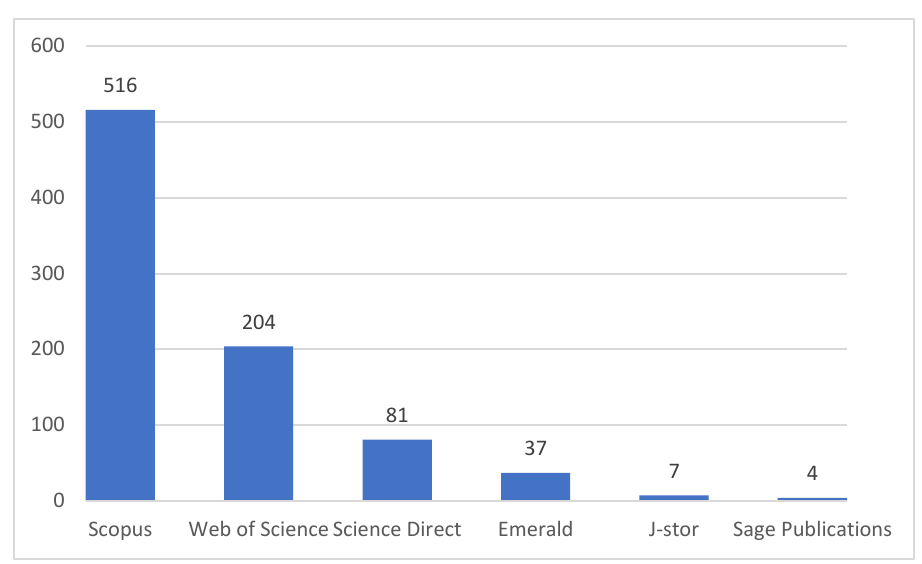
Figure 2. Results of initial search string, last update: November 2019.